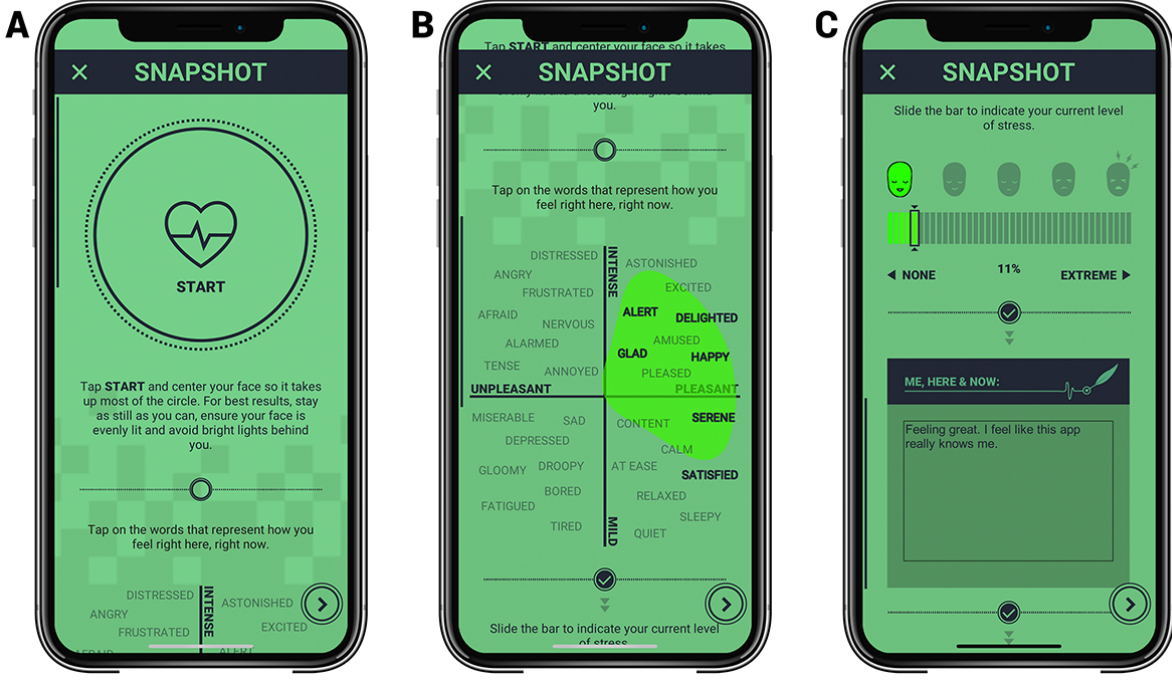
cognitive distortions with cancer-related examples; coping with thoughts and fears of cancer